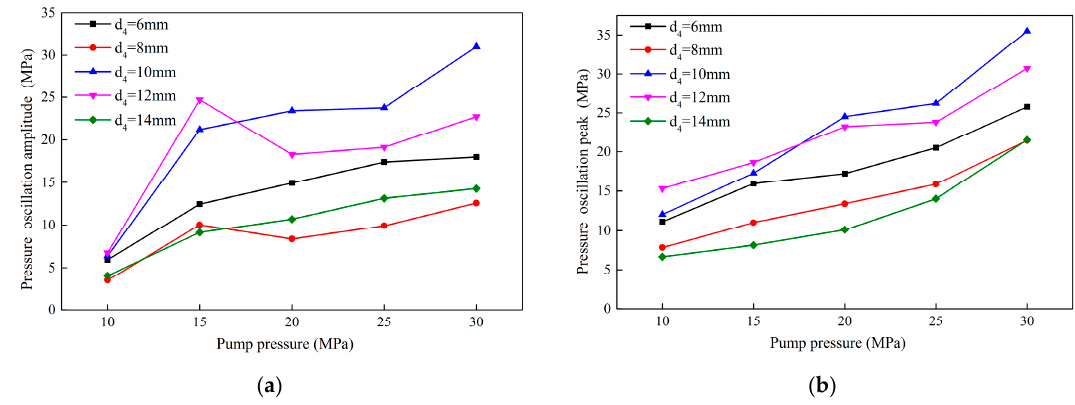
Figure 15. Performance of different d 4 nozzles under each pump pressure. ( a ). maximal jet pressure pulsation amplitudes of different d 4 nozzles. ( b ). maximal jet peak pressures of different d 4 nozzles at each pump pressure.